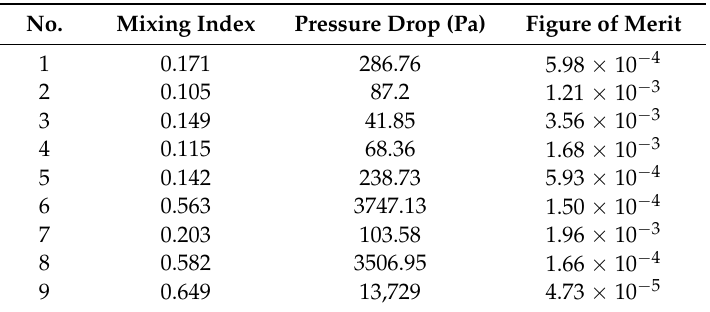
Table 3. Numerical results of various combination of design factors.